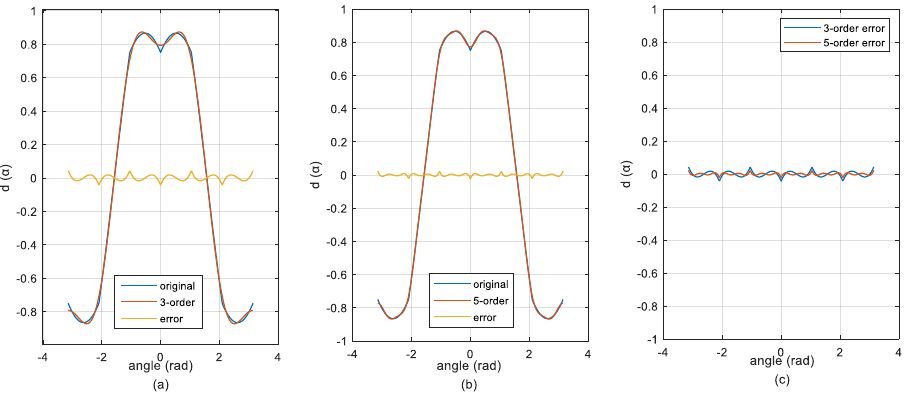
Figure 3. The waveform of d ( α ) , d 3 ( α ) and d 5 ( α ) . ( a ) Comparison of the waveform for d ( α ) and d 3 ( α ) . ( b ) Comparison of the waveform for d ( α ) and d 5 ( α ) . ( c ) Error comparison.